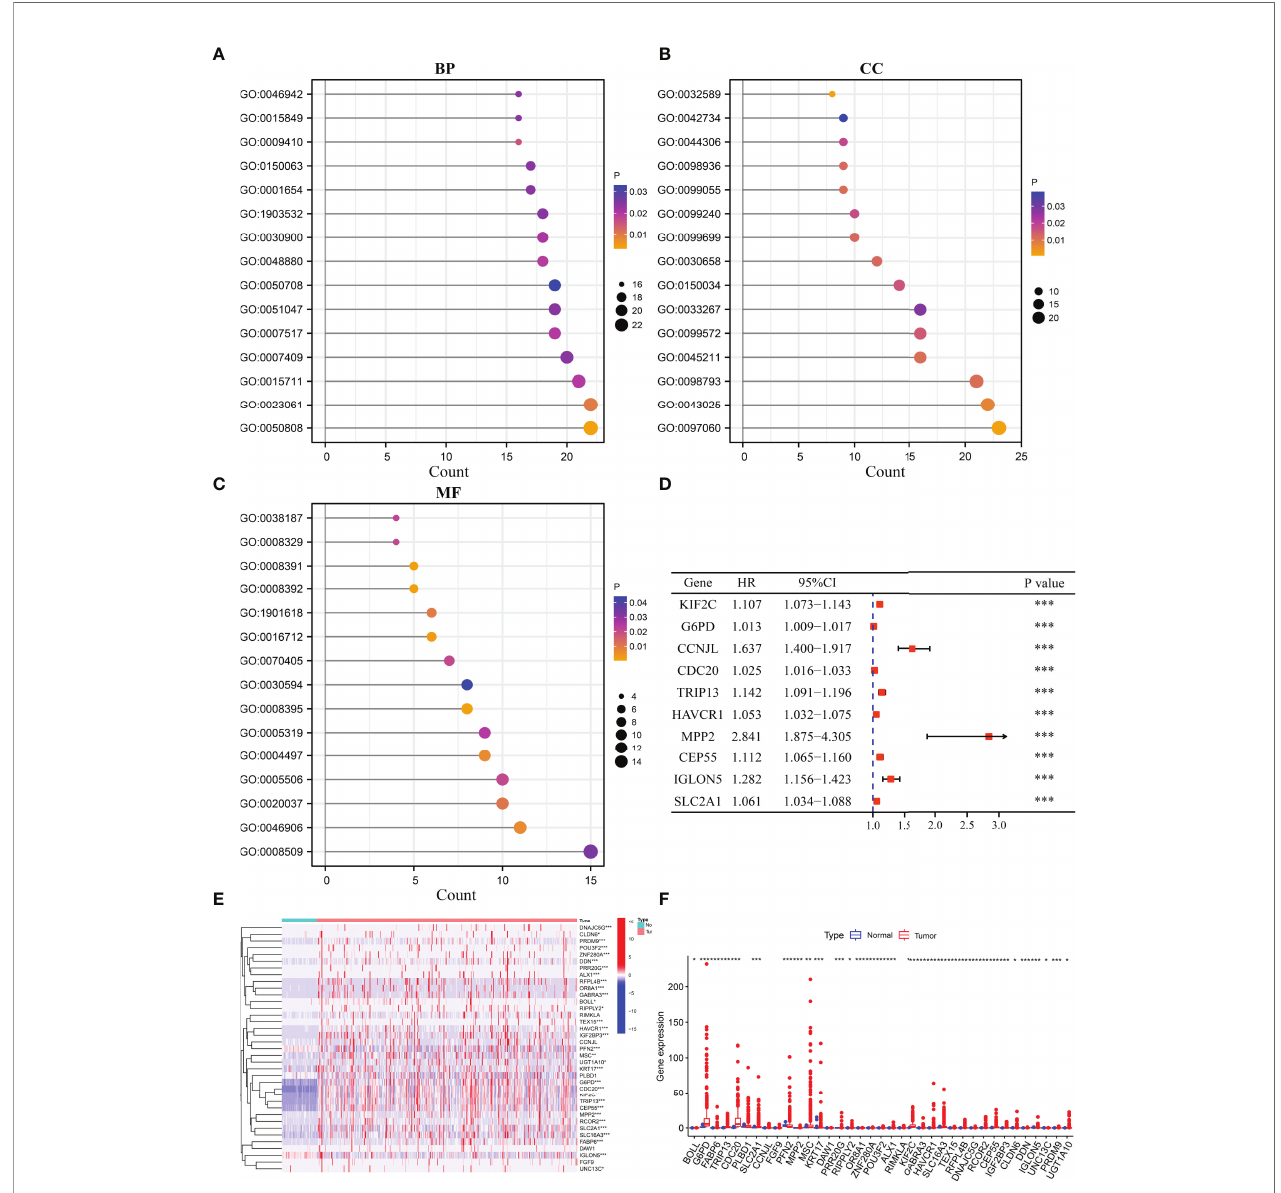
FIGURE 3 | The expression levels and roles of cluster-related DEGs. (A – C) The biological functions of cluster-related DEGs. (D) The prognostic value of cluster- related genes as determined using the Cox analysis. (E, F) The expression of cluster-related genes. BP, biological process; CC, cellular component; MF, molecular function; DEGs, differentially expressed genes; *P < 0.05; **P < 0.01; ***P <